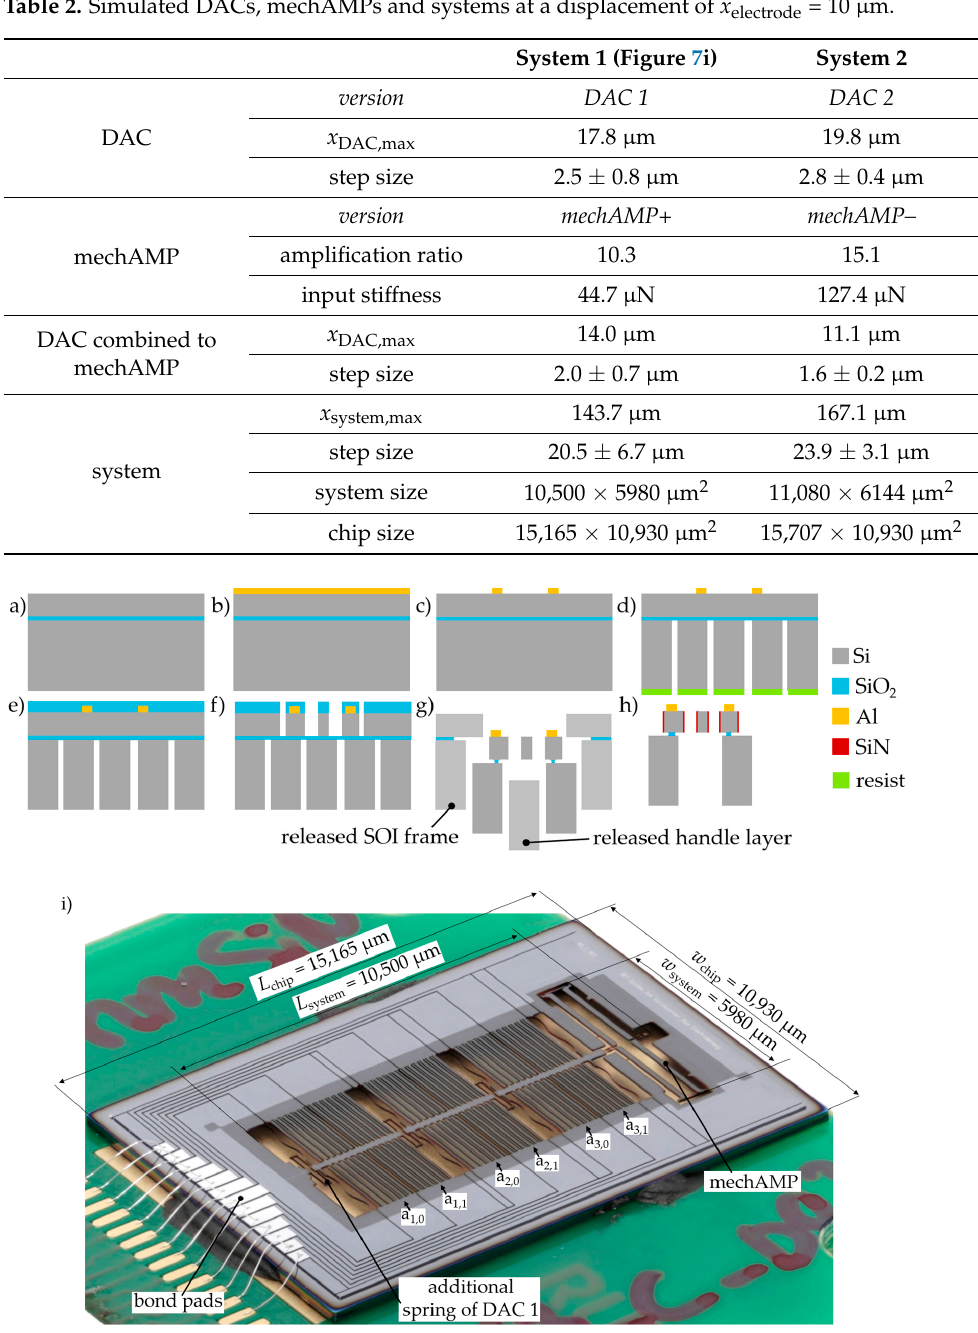
Figure 7. Fabrication process (drawings not to scale): ( a ) SOI Wafer, ( b ) deposition of the aluminum layer, ( c ) etching of the bond pads, ( d ) deep etching of the handle layer, ( e ) PECVD of 400-nm SiO 2 , ( f ) deep etching of the device layer, ( g ) HF vapor etching, ( h ) deposition of 400-nm SiN and ( i ) fabricated chip fixed and wire-bonded to a circuit board (stacked device